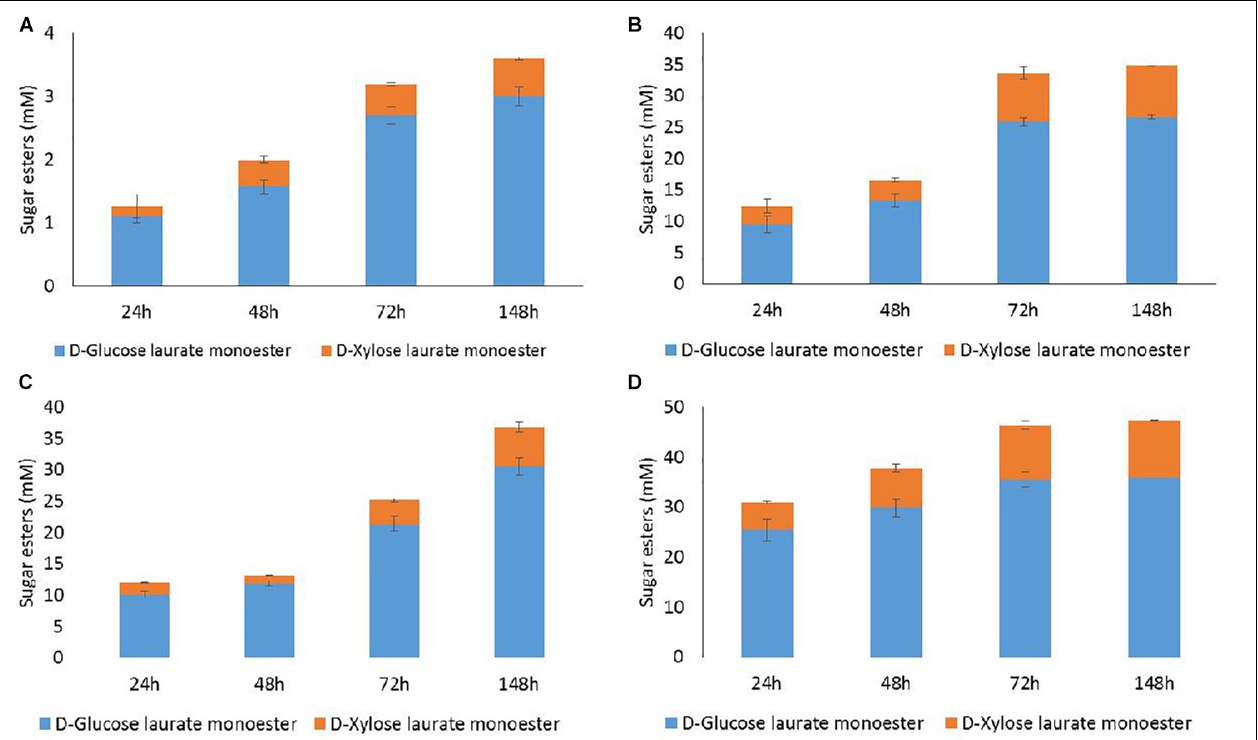
FIGURE 4 | HPLC quantification of D-glucose and D-xylose laurate esters recovered from acylation reactions performed with the lipase N435 in 2M2B from WB hydrolysate at 100 mM (D-glucose + D-xylose) and lauric acid at 100 mM (A) or 300 mM (B) , methyl laurate at 100 mM (C) 300 mM (D) . Error bars were obtained from triplicate